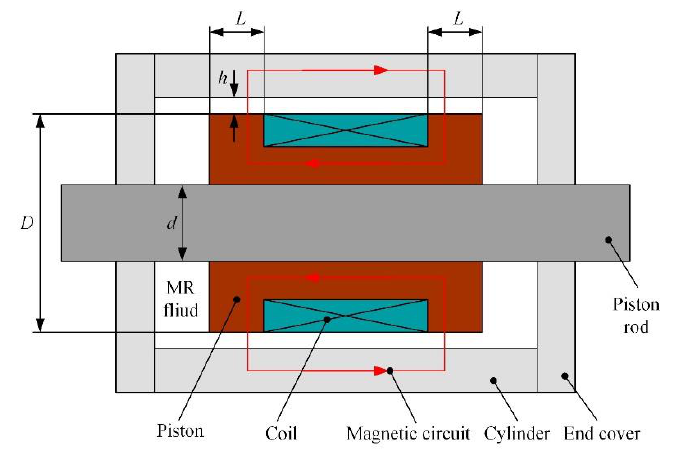
Figure 4. Structure of the MR buffer.